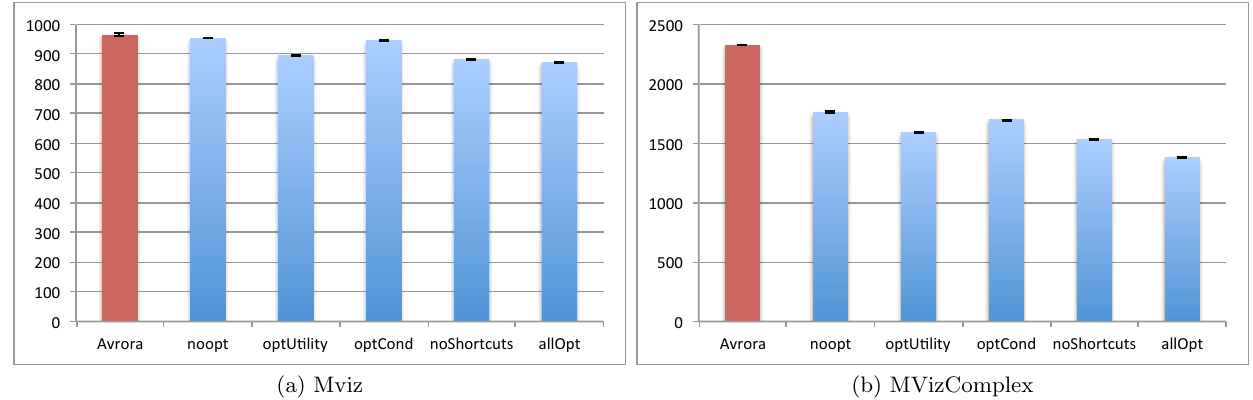
Figure 5: Network simulation performance for 100 nodes (wall time in